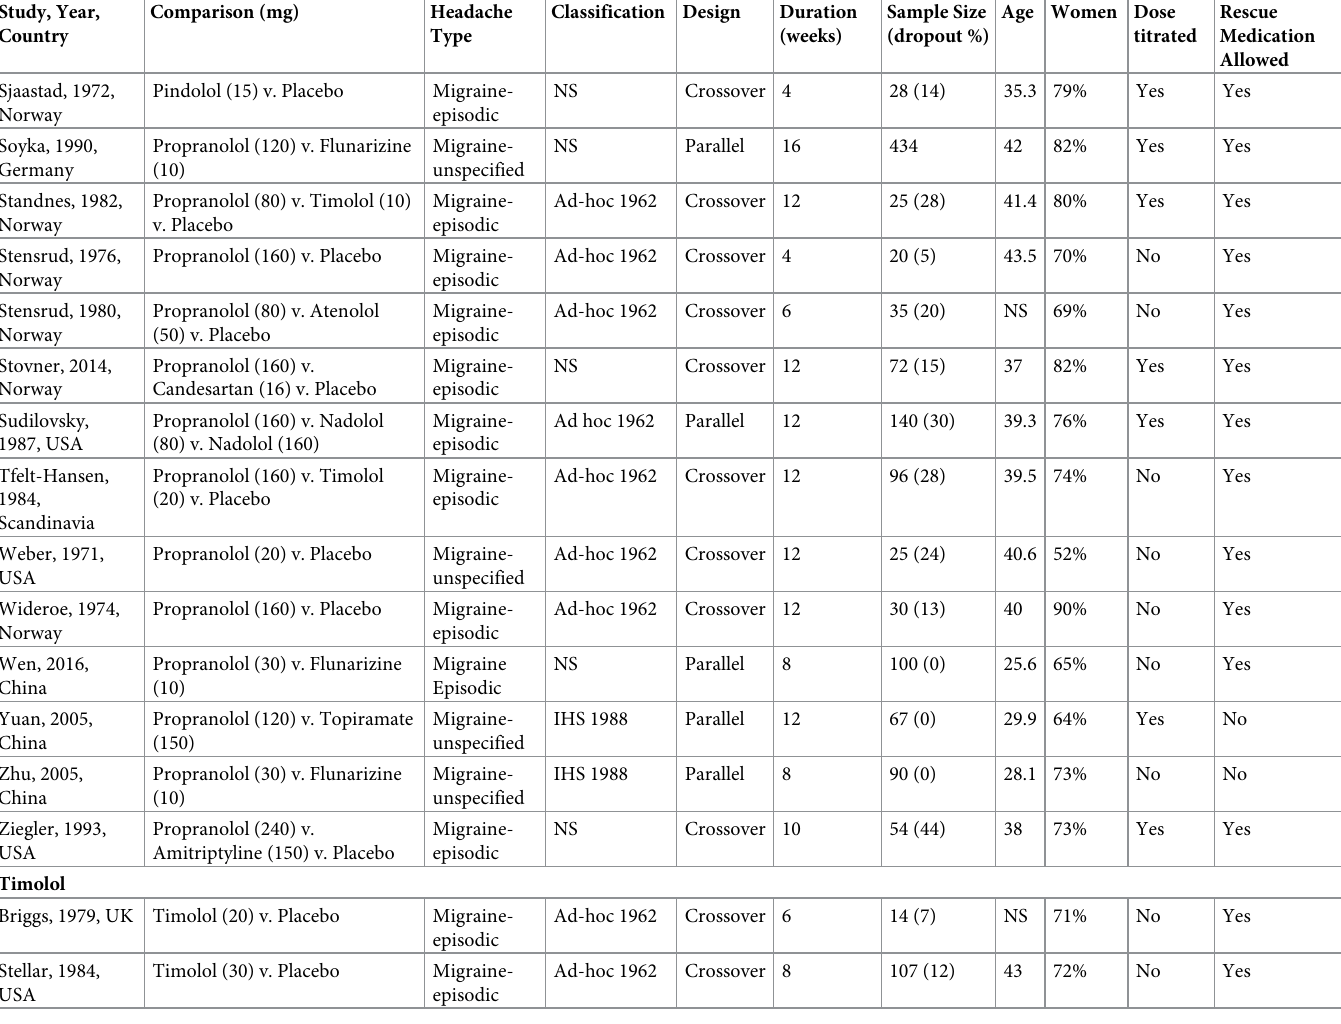
The primary outcome was headaches per month. Outcomes from placebo-controlled trials for all beta-blockers and time-points are provided in Tables 2–3. Outcomes at 8 weeks was the most commonly reported time point. Among patients with episodic migraines (Table 2), the average number of headaches at baseline was 4.9 headaches/month (95% CI: 4.4–5.4). The best studied beta-blocker was propranolol, which was more effective than placebo at 8 and 12 weeks (8 weeks: -1.5 ha/month, 95% CI: -2.3 to -0.65); 12 weeks: -1.2 ha/month, 95% CI: -1.8 to -0.60, Fig 2). Propranolol outcomes at 8 and 12 weeks were both graded as high-quality evi- dence. TSA analysis of propranolol vs. placebo for headache frequency demonstrated that it is unlikely that these results are due to a Type 1 error (Fig 3). Other beta-blockers that were more effective than placebo at 8 weeks (Fig 4) included bisoprolol (-0.70 ha/month, 95% CI: -1.4 to -0.05, low quality), metoprolol (-0.86 ha/month, 95% CI: -1.4 to -0.34, moderate quality) and